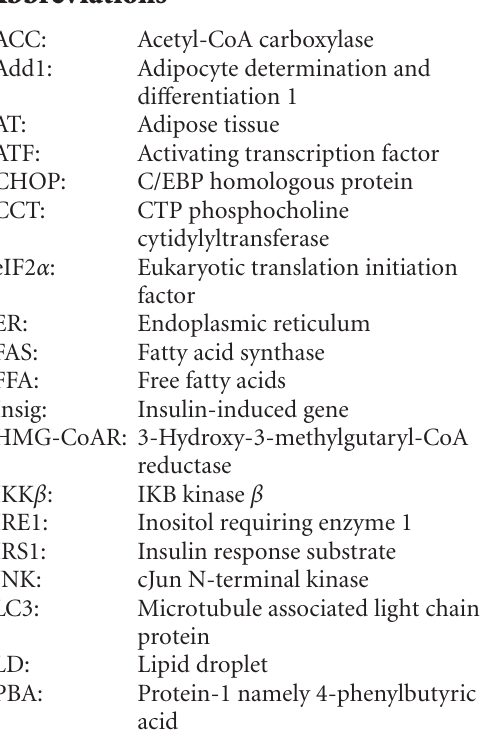
Inhibiting ER stress activation may be the key to an approach for metabolic syndrome therapy. However, more questions remain in this field. Namely, the role of all parts of the UPR in adipocyte lipid metabolism needs to be uncovered, and the mechanism intertwining ER stress and autophagy needs to be further elucidated. Understanding these missing components will allow not only further un- derstanding of key lipid pathways in a central metabolic cell type, but also help determine the best approach that can be utilized for clinical metabolic dysfunctions in patients with altered AT